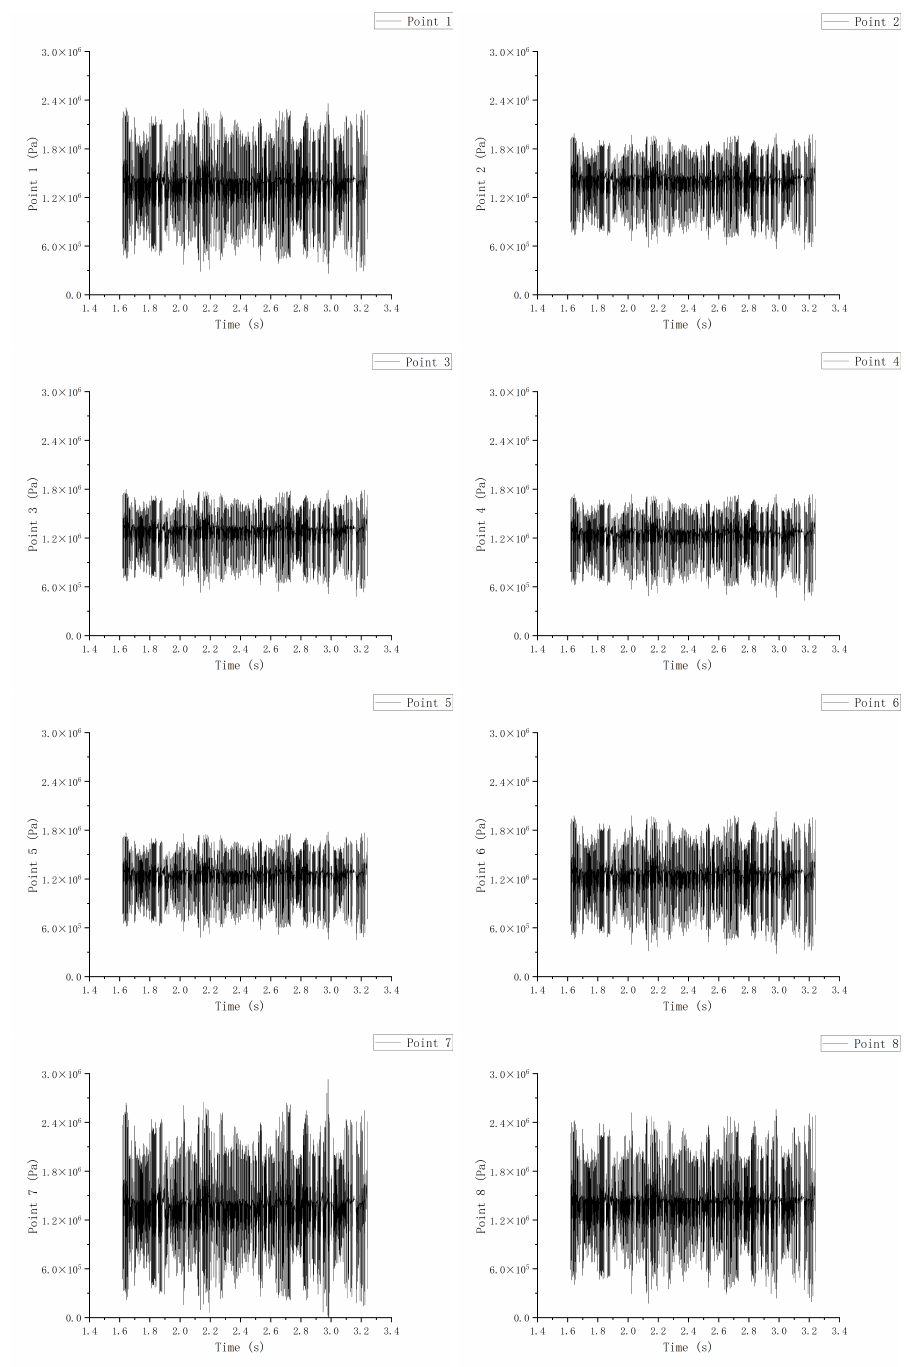
Figure 17. The pressure distributions of the upper crown